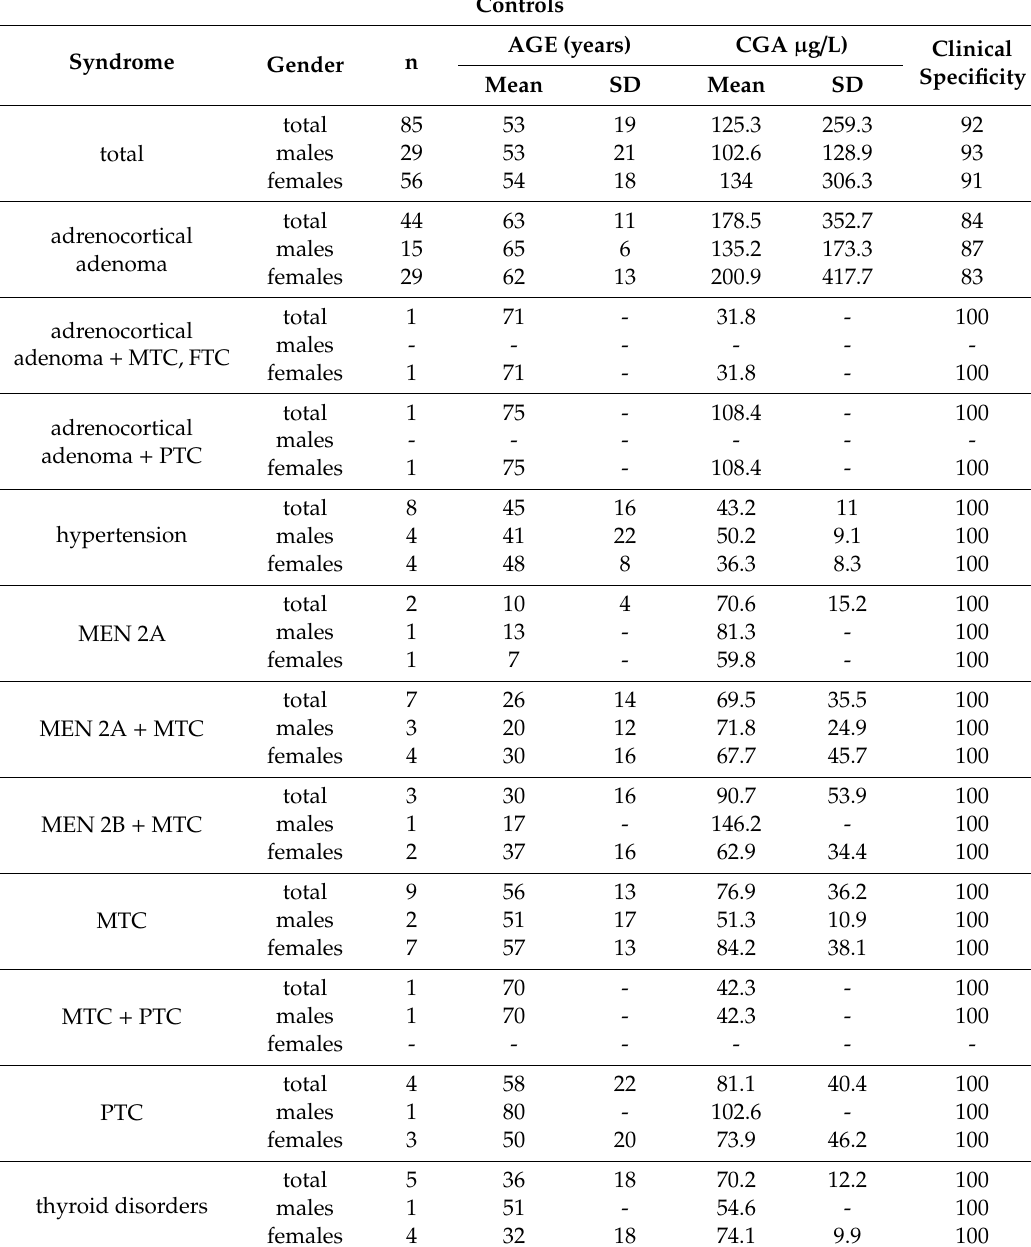
Table 2. The clinical specificity determined from the control group of patients with various adrenal disorders; but not a ffl icted by pheochromocytoma or paraganglioma. The meaning of abbreviations is plasma chromogranin A (CGA); multiple endocrine neoplasia (MEN) type 2A (MEN2A) or 2B (MEN2B); medullary (MTC); papillary (PTC) or follicular (FTC) thyroid carcinoma; number (n); standard deviation